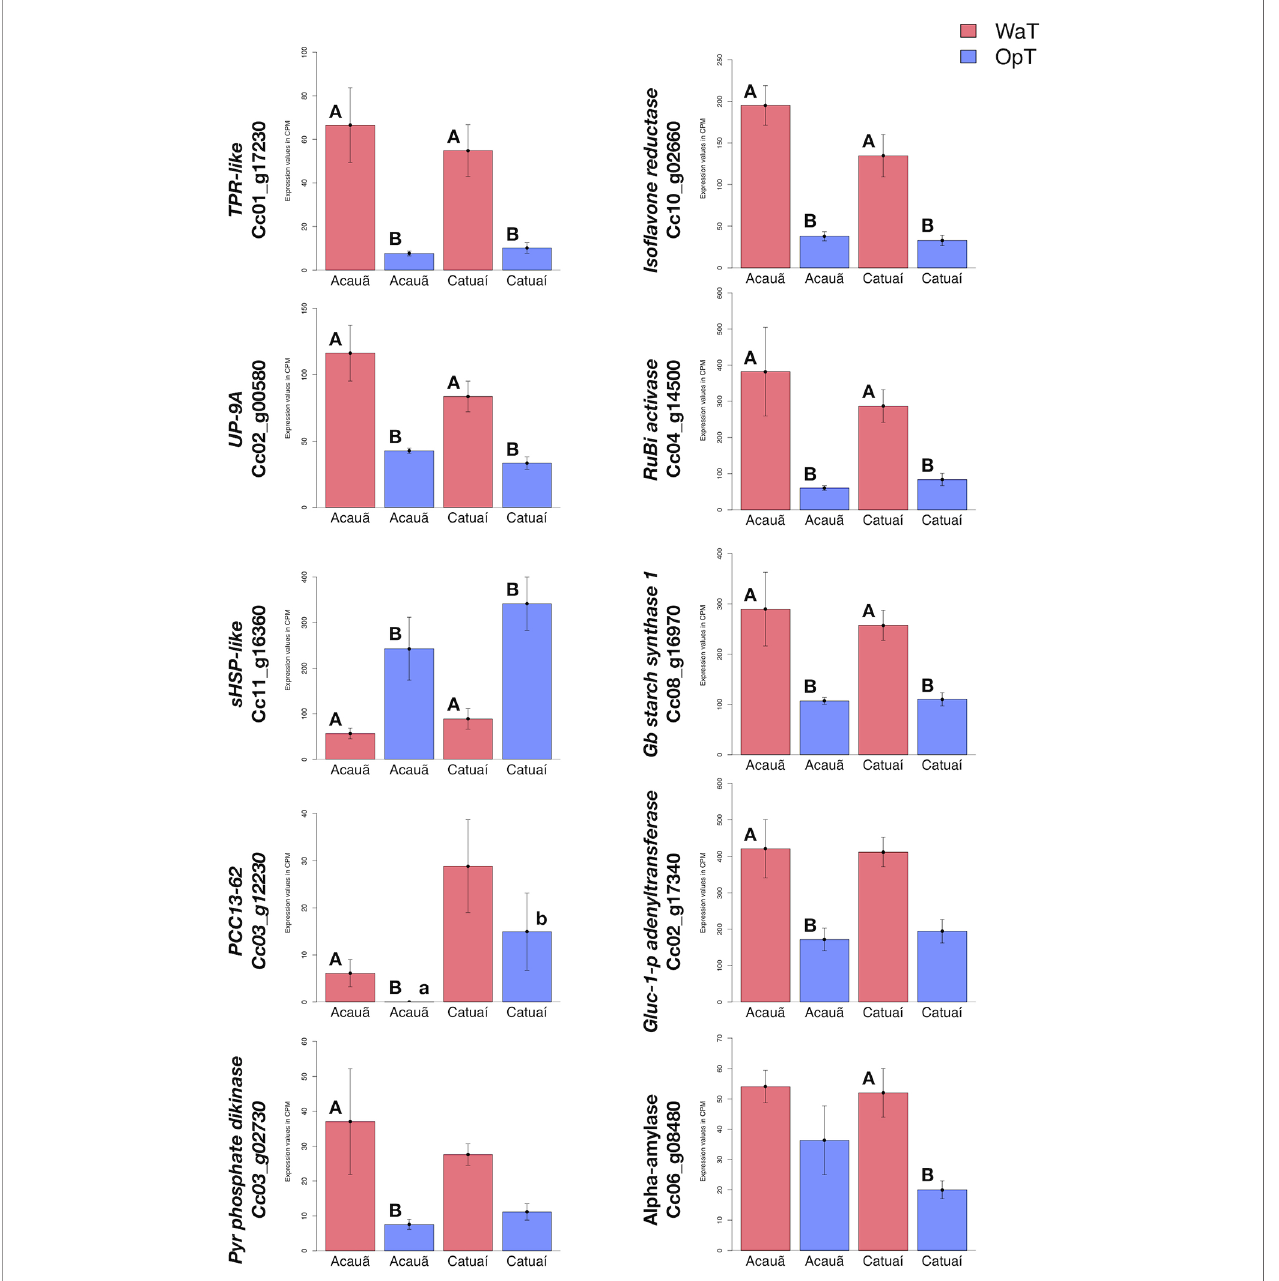
FIGURE 3 | RNAseq expression analysis of warm-responsive DEGs related to energy metabolism and thermotolerance. Based on analysis of DEGs ( Figure 2D and Table S2 ), we evaluated RNAseq expression of ten DEGs related to energy metabolism and thermotolerance; six DEGs that were shared between the two genotypes and four that were exclusive to one of the two genotypes, three in cv. Acauã and one in cv. Catua ı ́ , respectively: the TPR-like (Cc01_g17230), iso fl avone reductase (Cc10_g02660), UP-9A (Cc02_g00580), RuBisCO activase (RuBi activase; Cc04_g14500), small heat shock protein like (sHSP-like; Cc11_g16360), and granule-bound starch synthase 1 (Gb starch synthase 1; Cc08_g16970); desiccation-related_protein_PCC13-62 (PCC13-62; Cc03_g12230), glucose-1-phosphate adenyltransferase (Gluc_1_p_adenyltransferase; Cc02_17340); pyruvate phosphate dikinase (PPDK; Cc03_g02730); and alpha-amylase (Cc06_g08480). Statistical analyses were performed comparing the same coffee genotype at different temperatures (capital letters) and comparing different genotypes at the same temperature (small letters). Differences were considered signi fi cant at p<0.05 (see Table S2 for details). Error bars represent standard errors. Labels: OpT (blue columns), optimal temperature (23/19°C, day/night); WaT (red columns), warm temperature (30/26°C, day/night). Catua ı ́ both under OpT or WaT had fi ve biological repetitions, as well as Acauã under WaT. Acauã under OpT had four biological repetitions. Error bars depict the standard